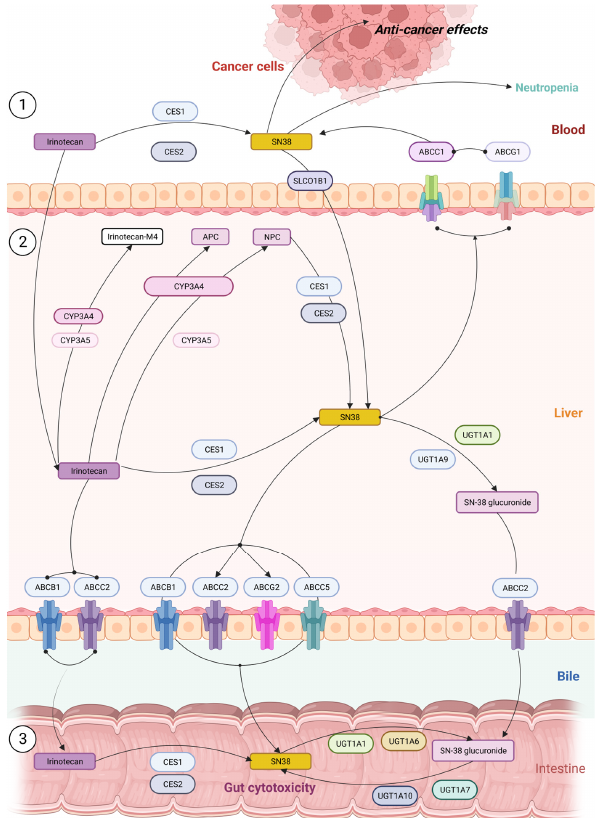
Figure 2. Pathways of irinotecan metabolism in the liver cells ① showing the conversion of inactive form to active SN-38 leading to neutropenia; ② the drug enters via ABC transporters where it is converted to derivatives irinotecan M4, APC, and NPC; ③ the excreted version of irinotecan or SN38G is reconverted to active form SN-38 in intestine and causes GI toxicity.